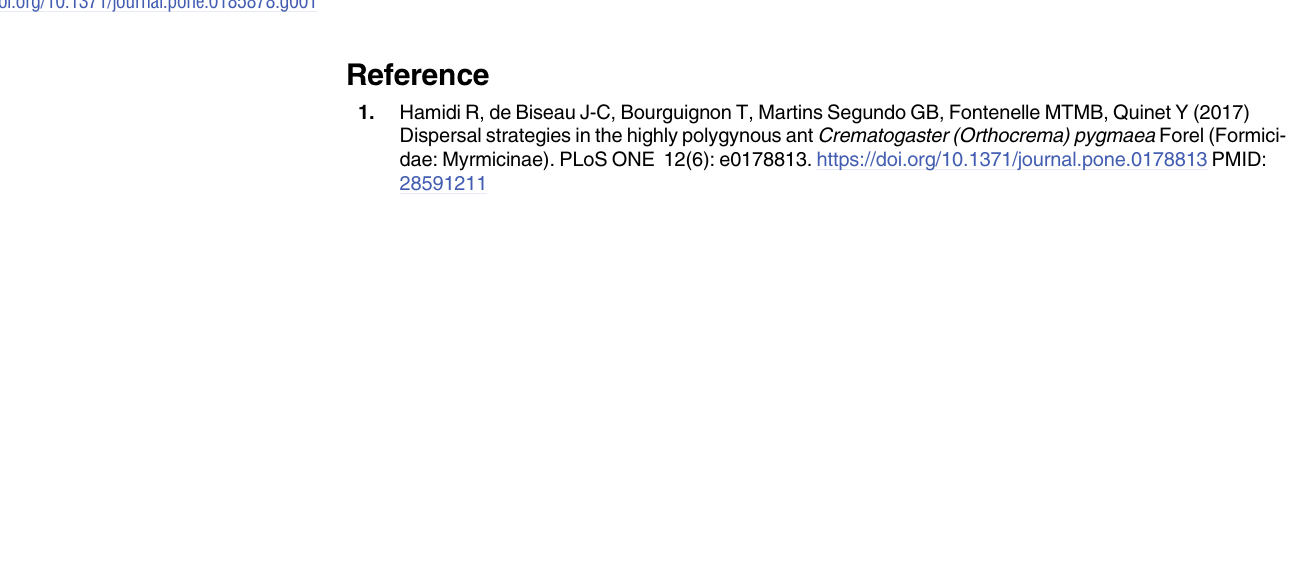
Fig 1. Morphological differences between a gyne (unmated winged queen) (A,C) and a mature queen (B,D). The gaster is yellowishin gynes while it is dark in mature queens.